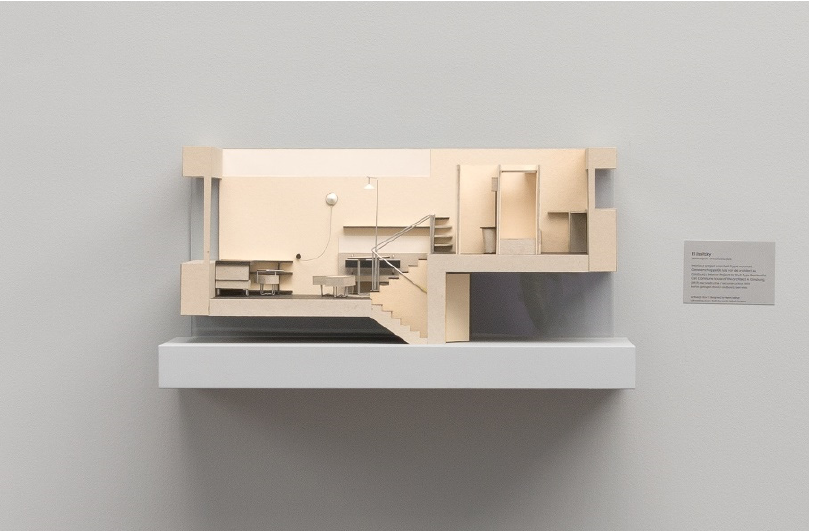
Figure 28. Model after El Lissitzky, Interior Project for the F-type Residential Cell, 1927, reconstruction by Henry Milner, 2012. Van Abbemuseum. Photo: Peter Cox.